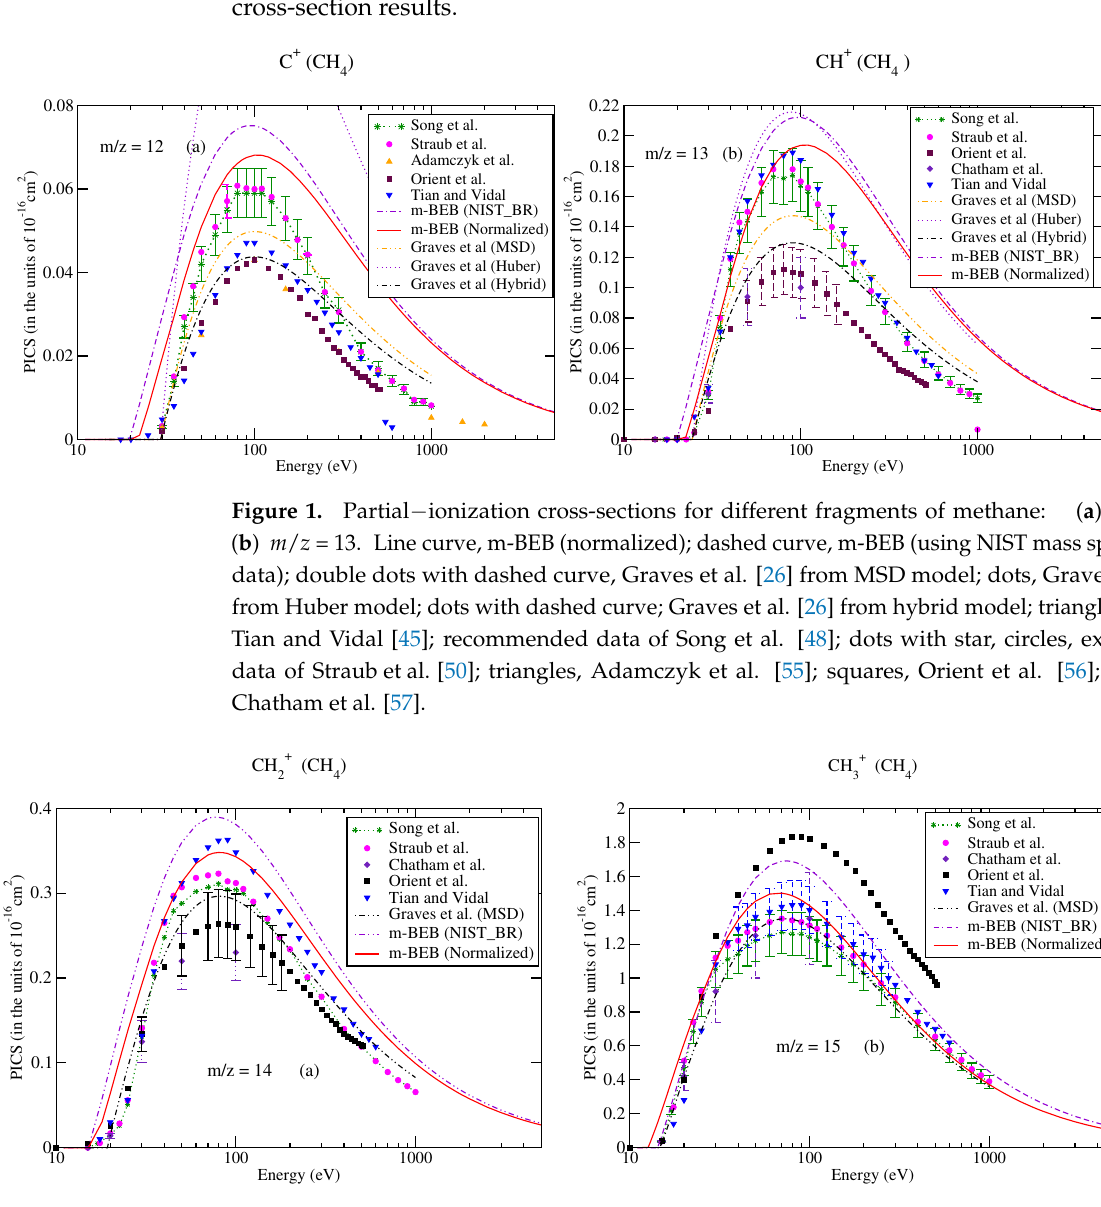
Figure 2. Caption same as Figure 1 but for ( a ) m / z = 14, ( b ) m / z =